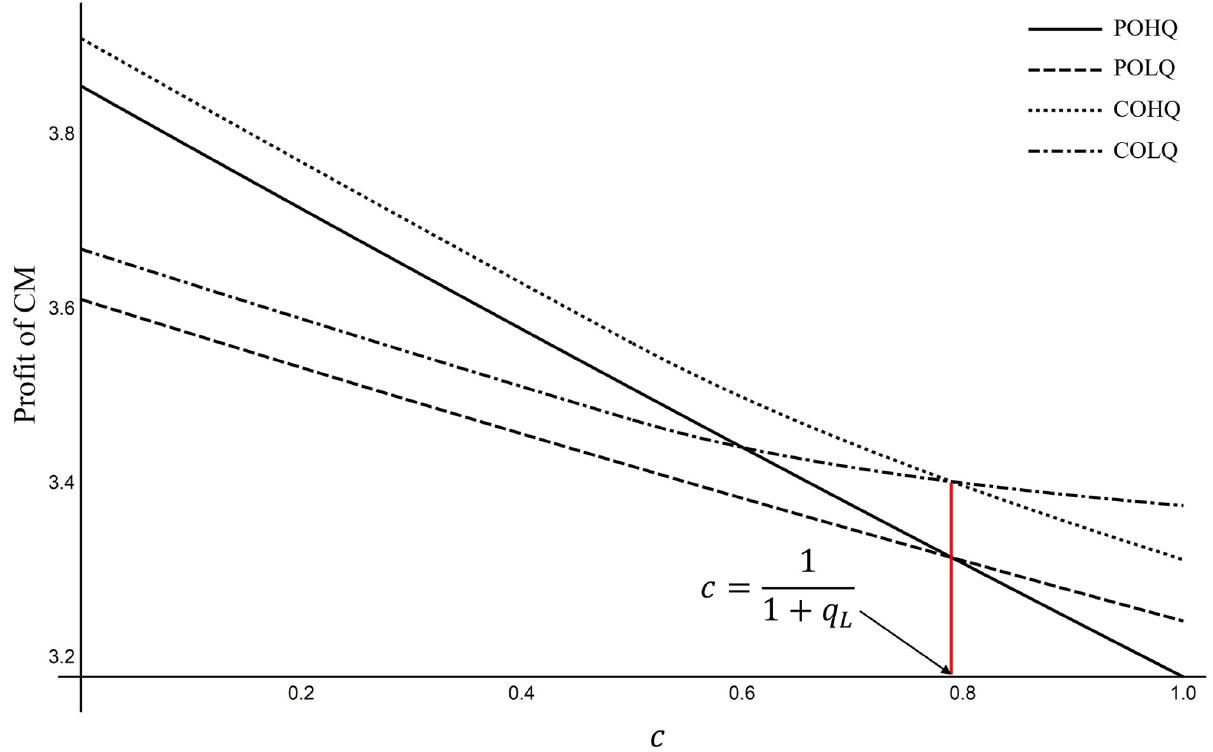
Fig 5. The influence of c on the profit of CM ( a = 1; α = 0.9; m = 0.152; q